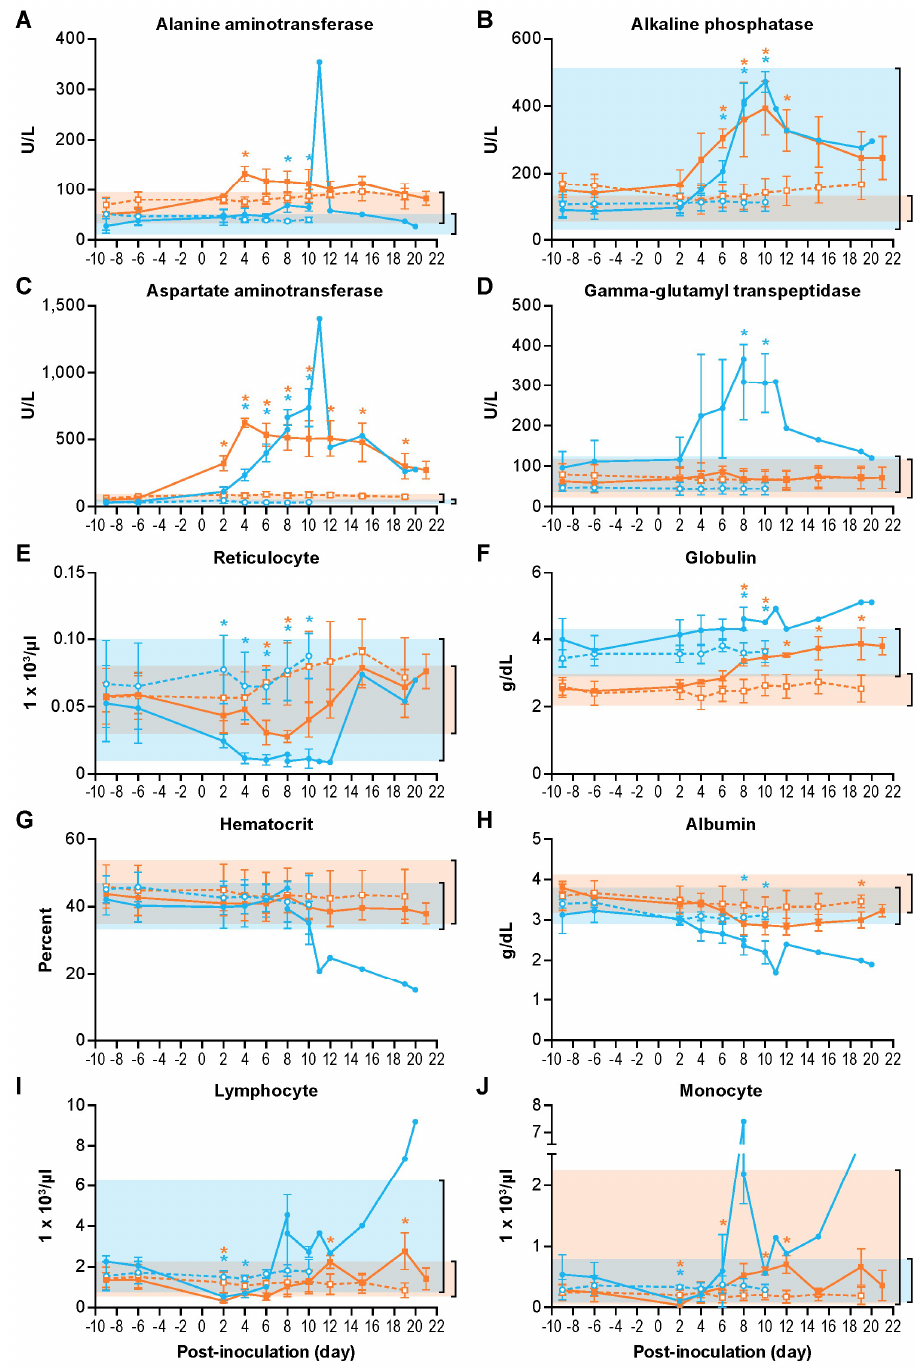
Figure 1. Clinical pathology changes during simian hemorrhagic fever virus (SHFV) infection. Alanine aminotransferase ( A ), alkaline phosphatase ( B ), aspartate aminotransferase ( C ), gamma- glutamyltransferase ( D ), reticulocyte number ( E ), globulin ( F ), hematocrit (HCT) ( G ), albumin ( H ), lymphocyte number ( I ), monocyte number ( J ) values for patas monkeys (orange lines) and rhesus monkeys (blue lines) either inoculated with 5,000 PFU of SHFV (closed symbols) or with PBS (open symbols). The shaded regions represent the standard range of all pre-exposure values for the patas monkeys or previously collected values for the rhesus monkeys. The data represent the means of each group. The error bars represent standard deviation. * symbols represent p < 0.05 and are colored according to